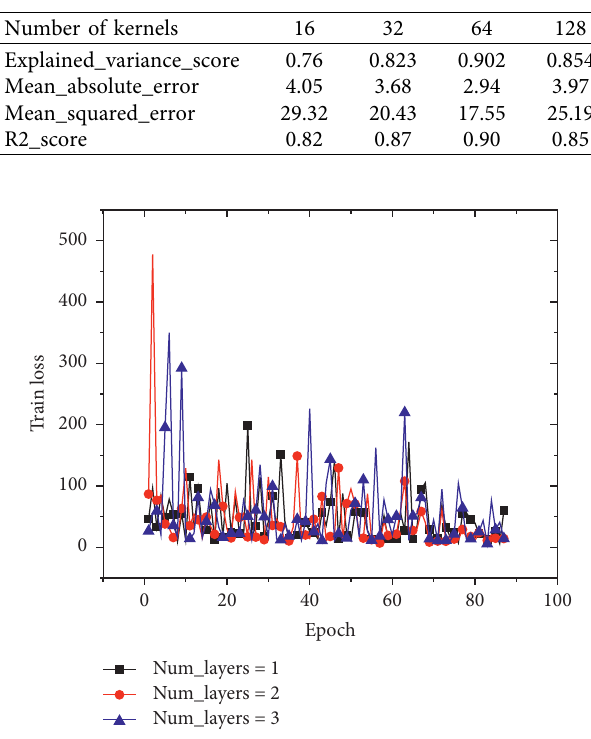
Figure 10: Train loss with different num_layers .